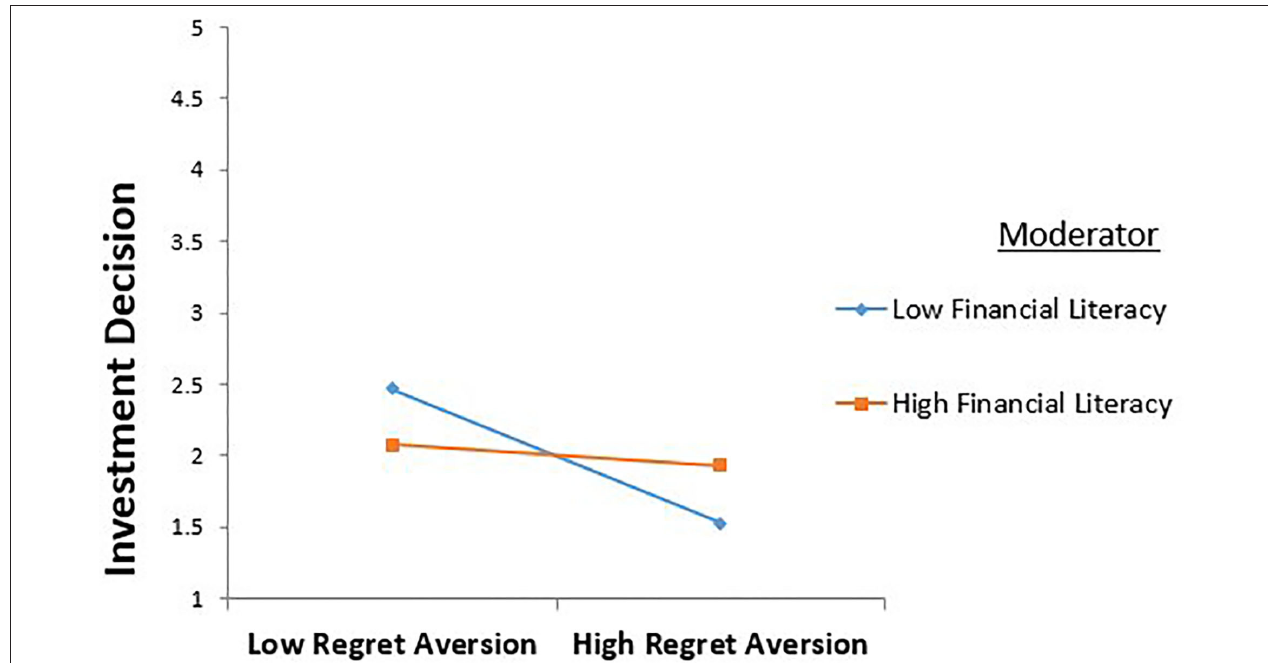
FIGURE 2 | Moderating role of financial literacy between regret aversion and investment decision.